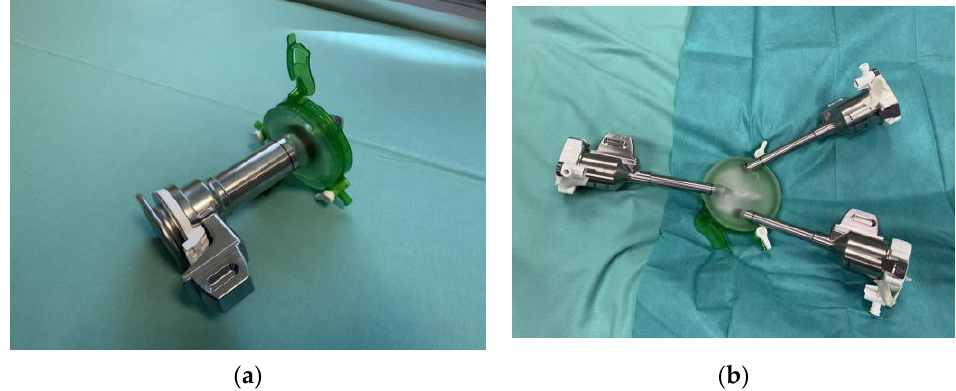
Figure 2. Trocar set up for da Vinci (Single Port) SP ( a ) and da Vinci Xi system ( b ) using a Gel Port.